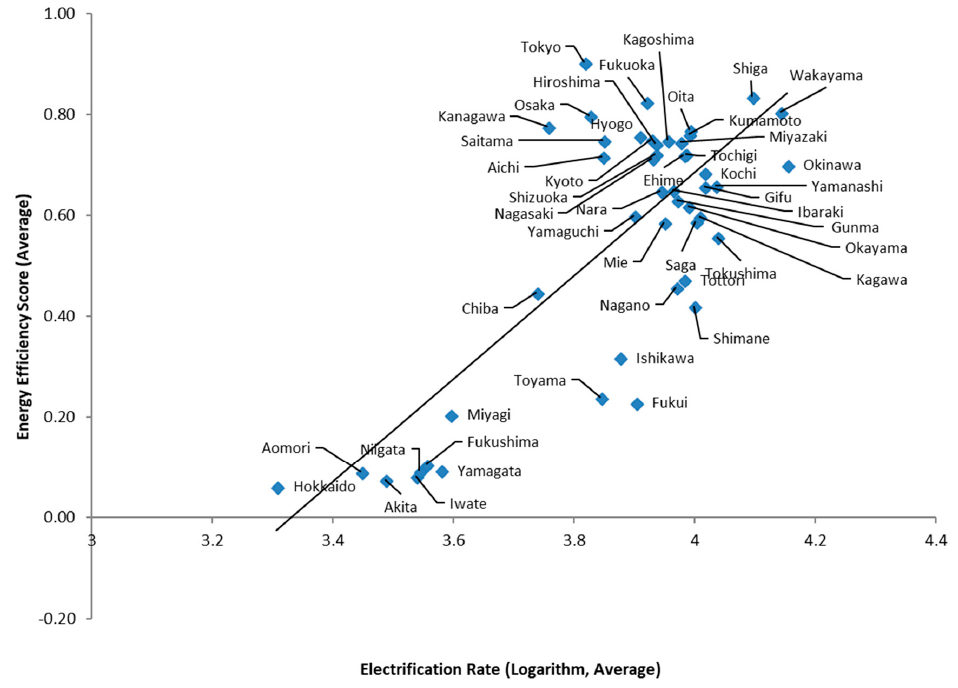
Figure 2. Static relationship between energy efficiency score and electrification rate.